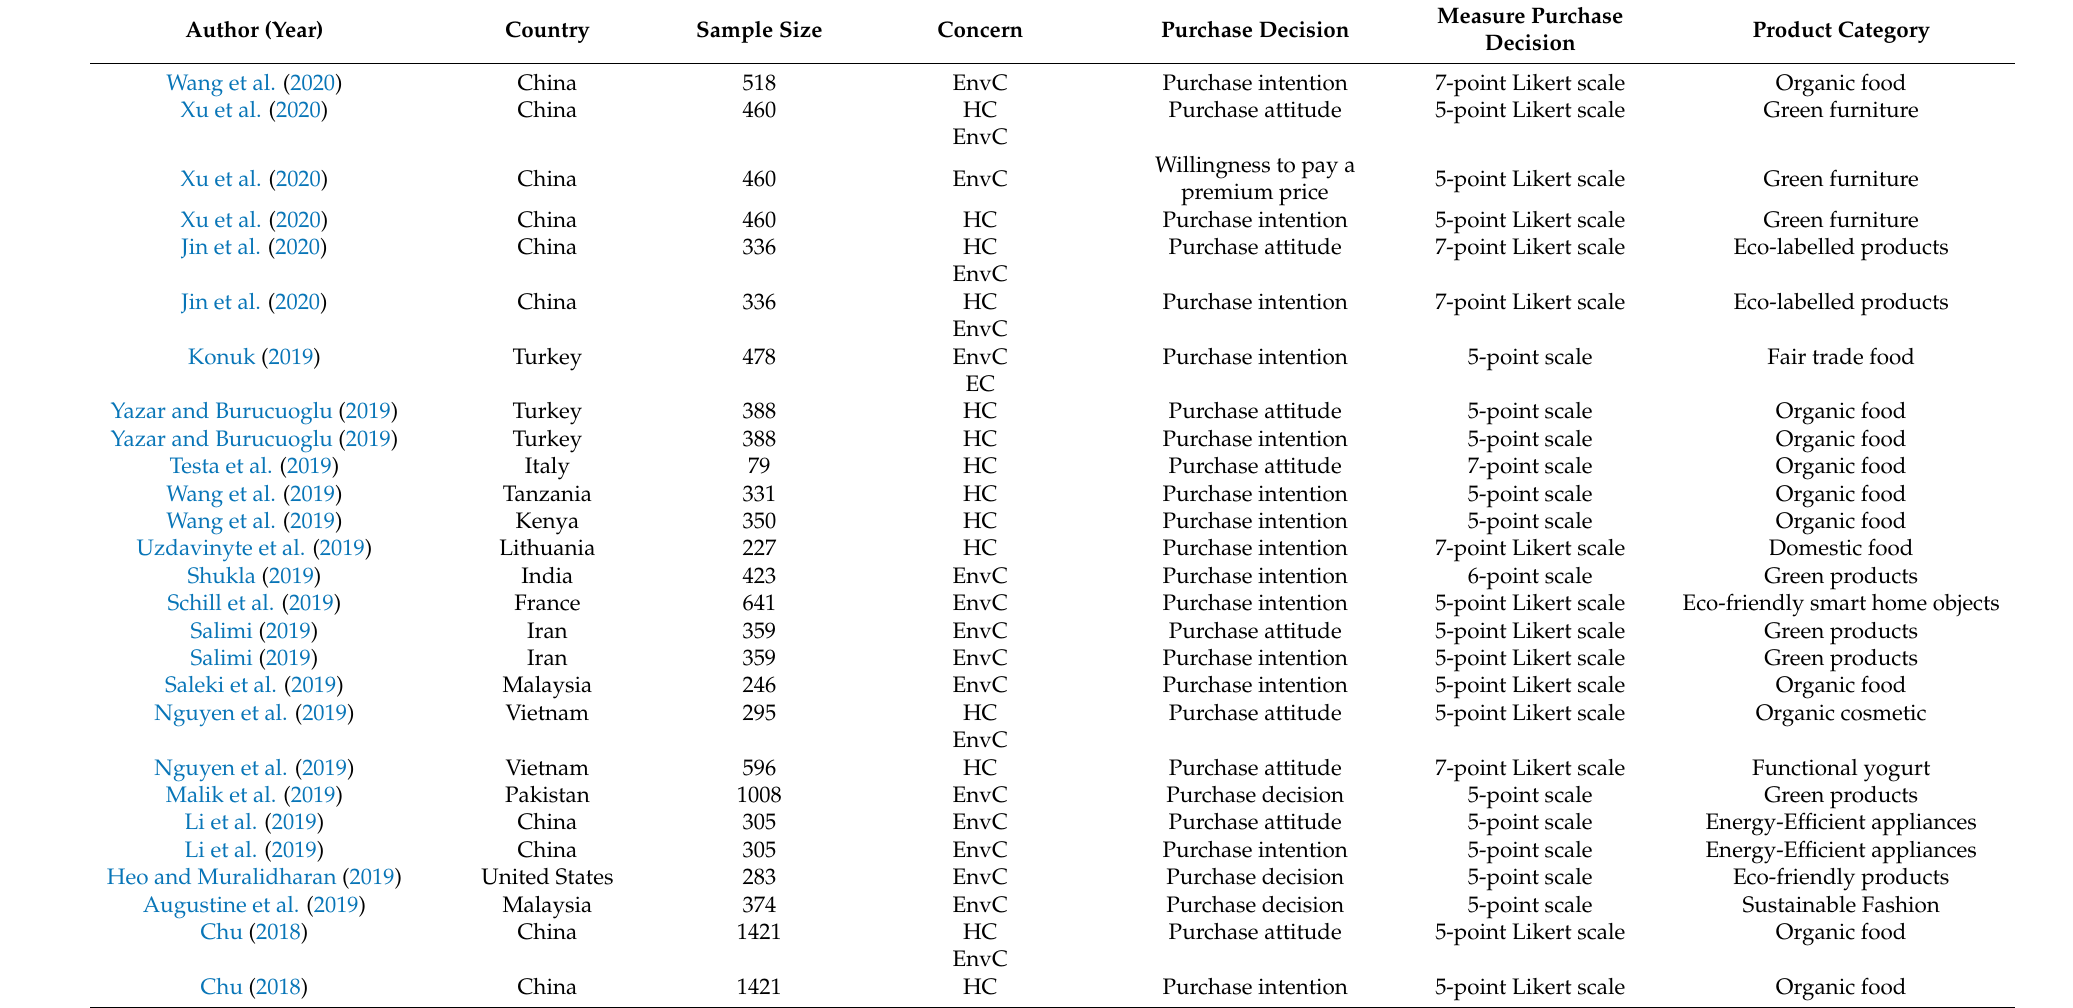
Table 2. Characteristics of the 54 studies included in the